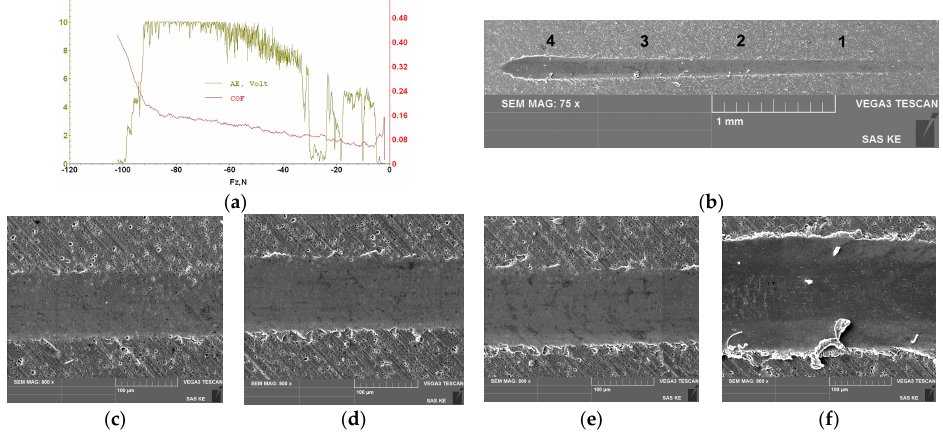
Figure 8. Acoustic emission of ZrN coating: ( a ) record AE-Fz, COF-Fz; ( b ) scratch–disposition and ( c – f ) detail of coating failure, position 1–4 respectively.